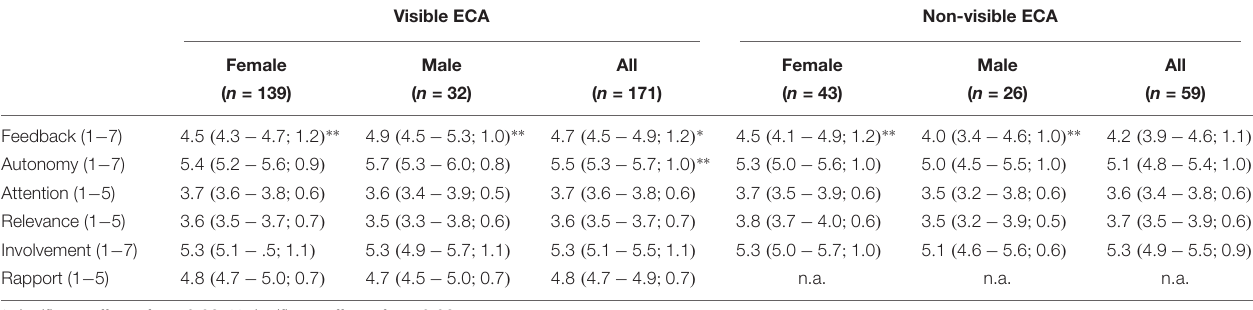
TABLE 1 | Mean scores and standard deviation on the visibility- non-visibility distinction.